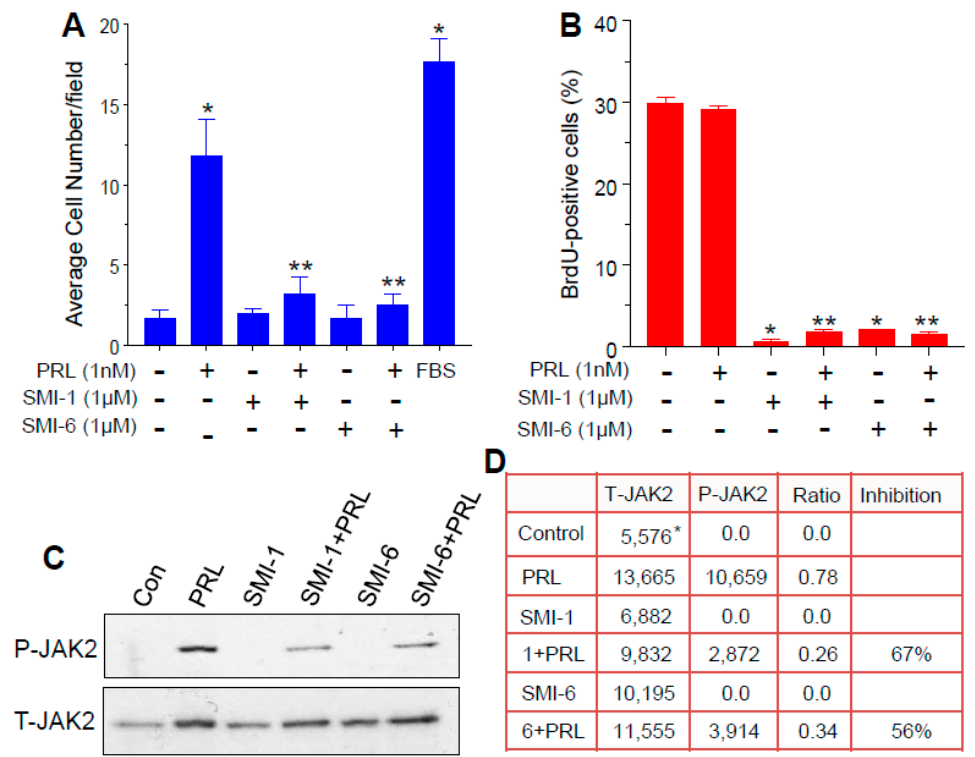
Figure 3. Antagonism of PRL actions by SMI-1 and SMI-6. ( A ) Inhibition of PRL-induced invasion of MDA-MB-468 cells by the SMIs, using Boyden chambers. Values are means ± SEM ( n = 3). FBS—10% fetal bovine serum. * significant ( p < 0.05) vs. control, ** significant ( p < 0.05) vs. PRL. ( B ) Suppression of EdU (5-ethynyl-2’-deoxy-uridine) incorporation in Jurkat lymphocytes by the SMIs, and lack of effect of added PRL. Values are means ± SEM ( n = 4). ( C ) Western blots showing suppression of PRL-induced JAK2 phosphorylation in hPRLR-expressing Ba/F3 by the SMIs. T-JAK2—total JAK2; P-JAK2—phosphorylated JAK2. ( D ) Densitometric quantification of P-JAK2 relative to T-JAK2 of 3 Western blot replicates.